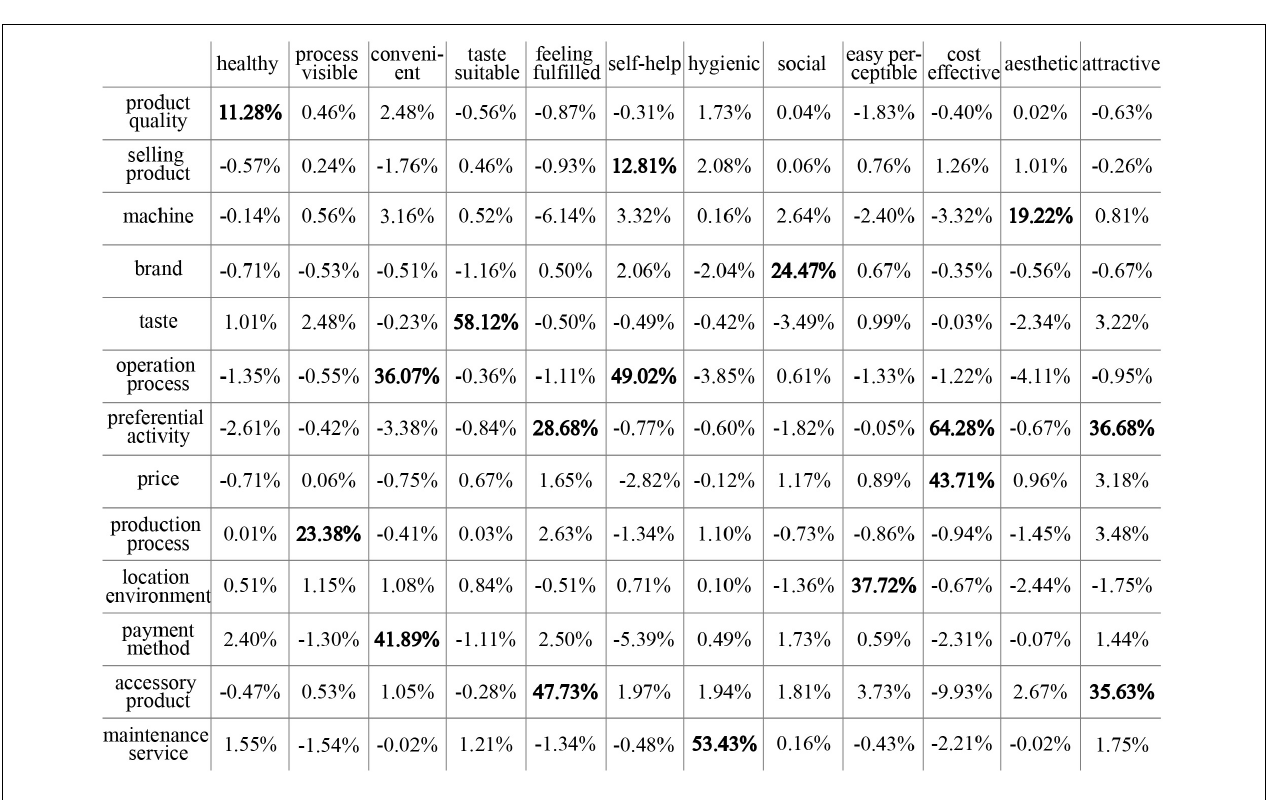
FIGURE 7 | Division of user concerns and product stimuli.